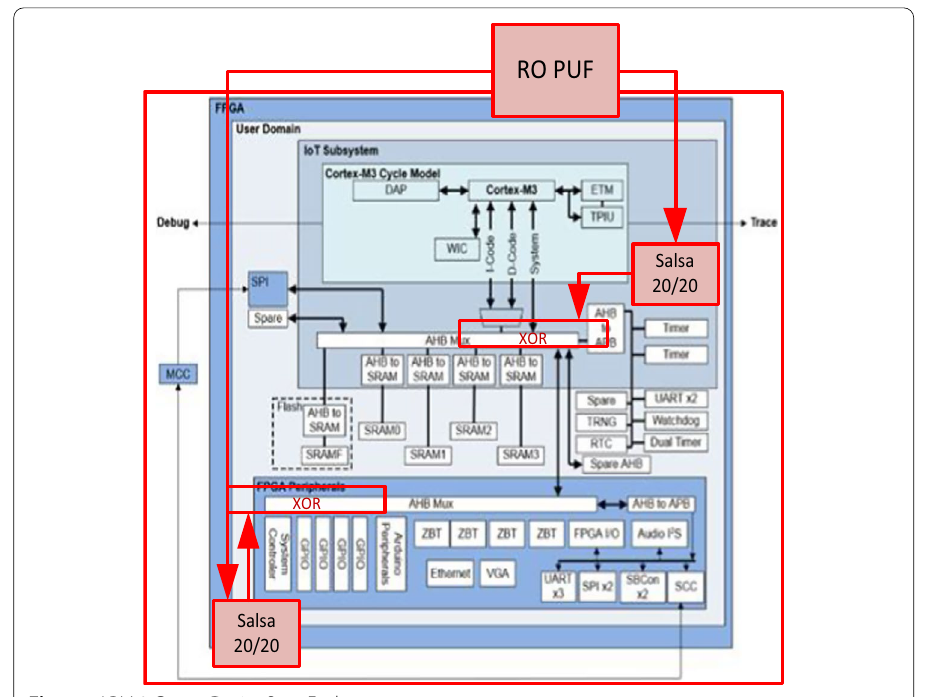
Fig. 11 ARM 3 Cortex DesignStart